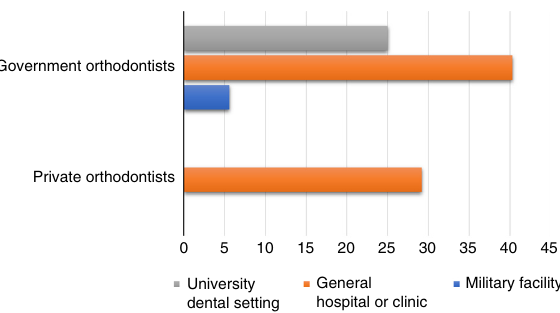
Figure 1. Breakdown of respondents based on service